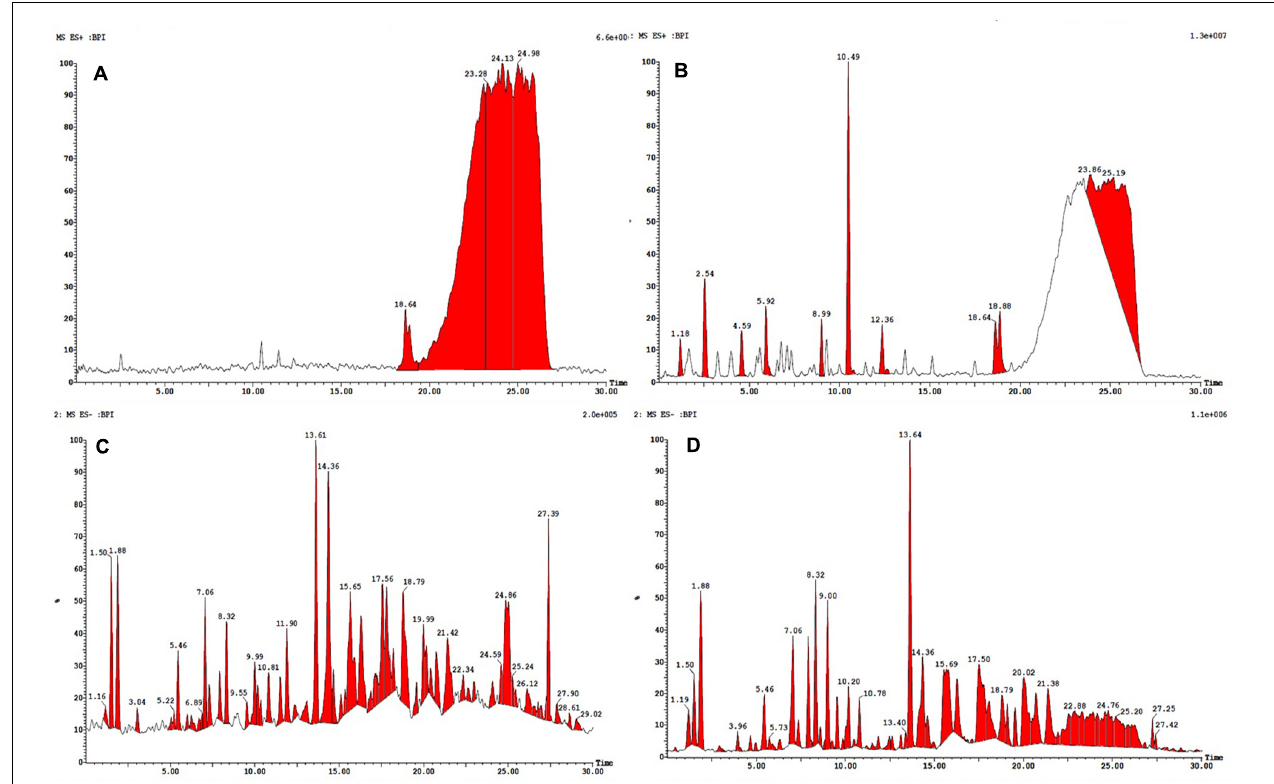
FIGURE 4 | HPLC-ESI-MS/MS base peak chromatogram (BPC) of metabolite (A) non-treated (positive), (B) treated with 100 nM BRD4770 (positive), (C) non-treated (negative), and (D) treated with 100 nM BRD4770